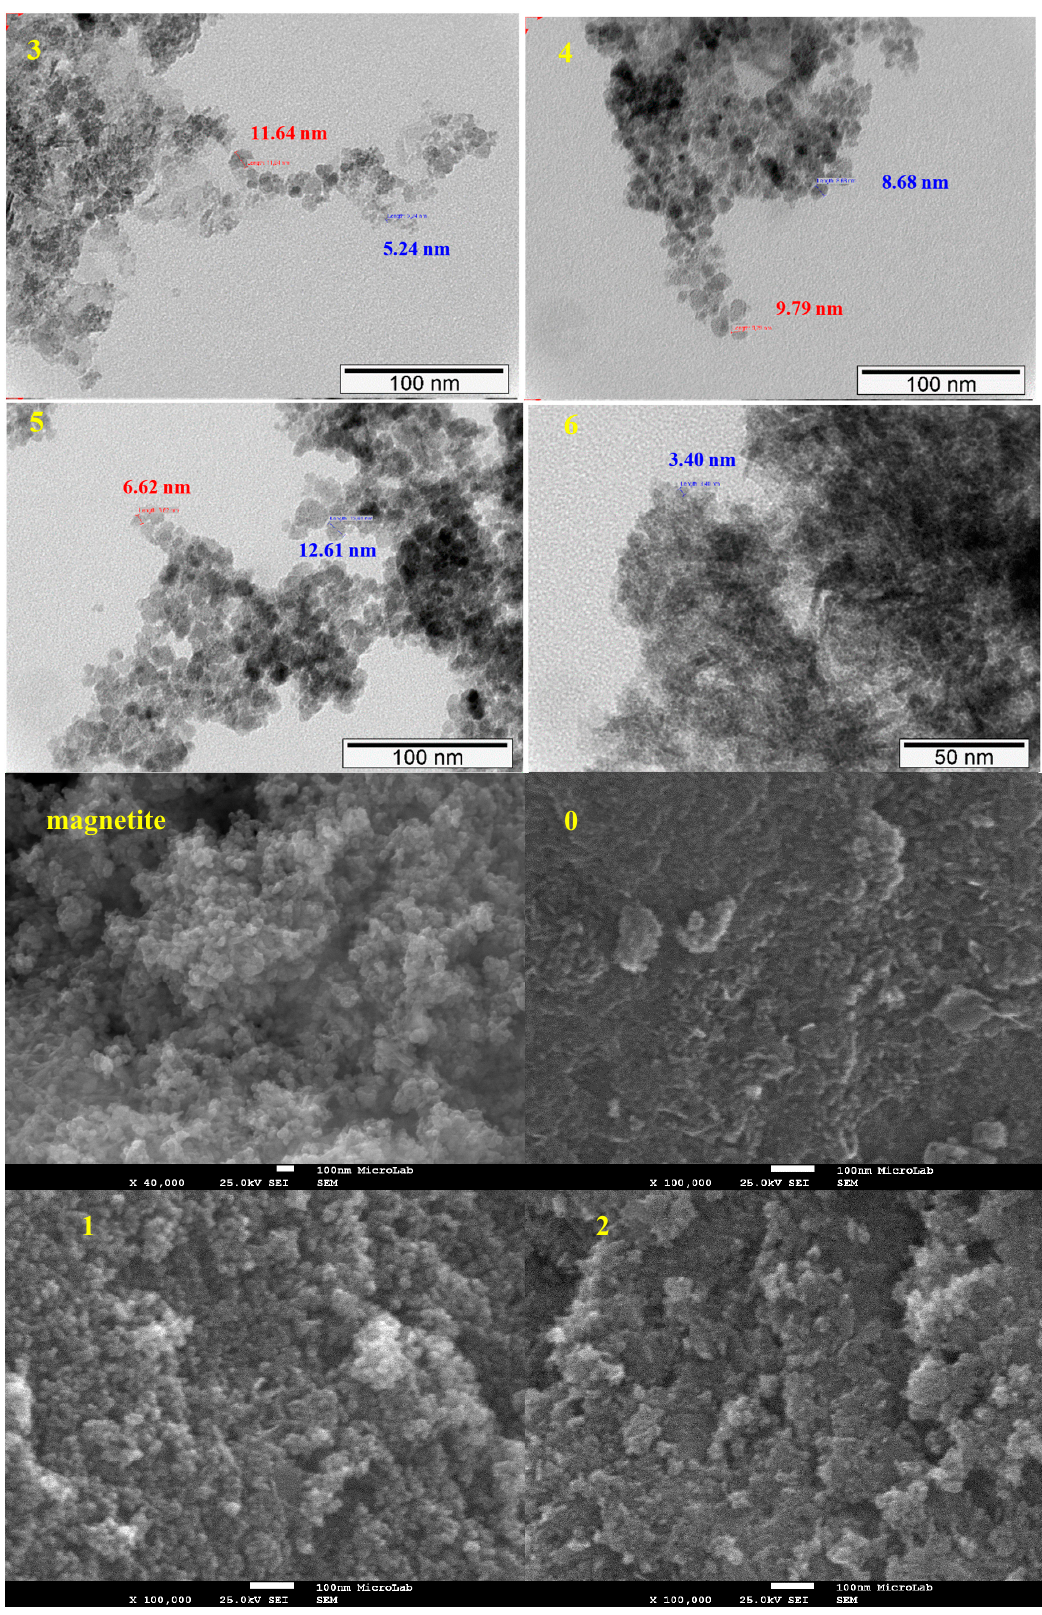
Figure 3. Cont . Figure 3.